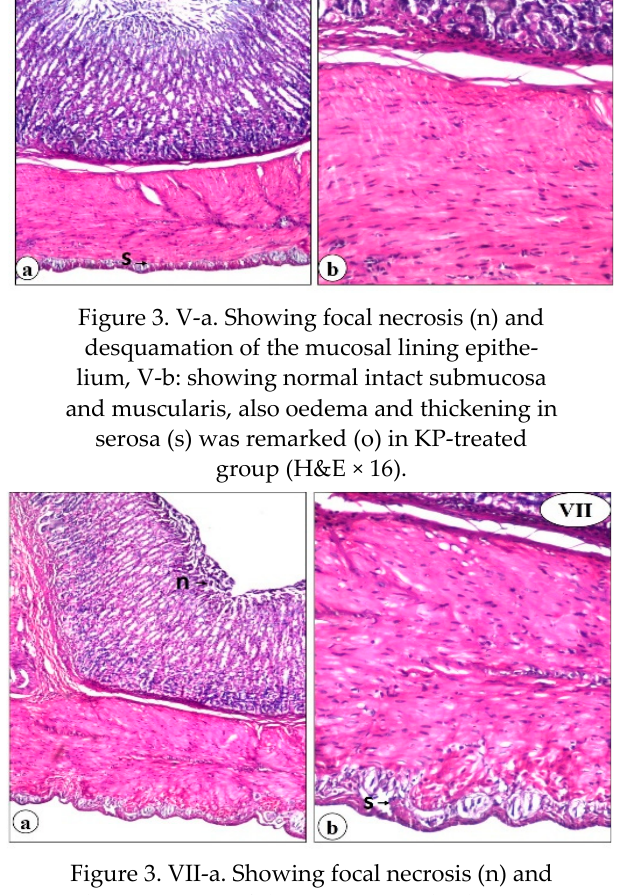
Figure 3. VII-a. Showing focal necrosis (n) and desquamation of the mucosa, VII-b: showing the VIIb magnification (×40) and oedema & thickening in serosa (s) in Lansoprazole- treated group (H&E × 16). Figure 3. Histopathological findings of different experimental Figure 3. Histopathological findings of different experimental groups. Table 7. The severity of histopathological alteration and underlying structure of stomach of different ex- perimental groups, n = 6.